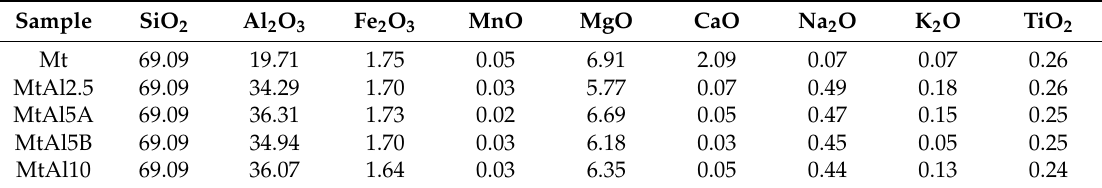
Table 3. Chemical composition of the water-free solids, normalized to the SiO 2 content in the raw montmorillonite (mass